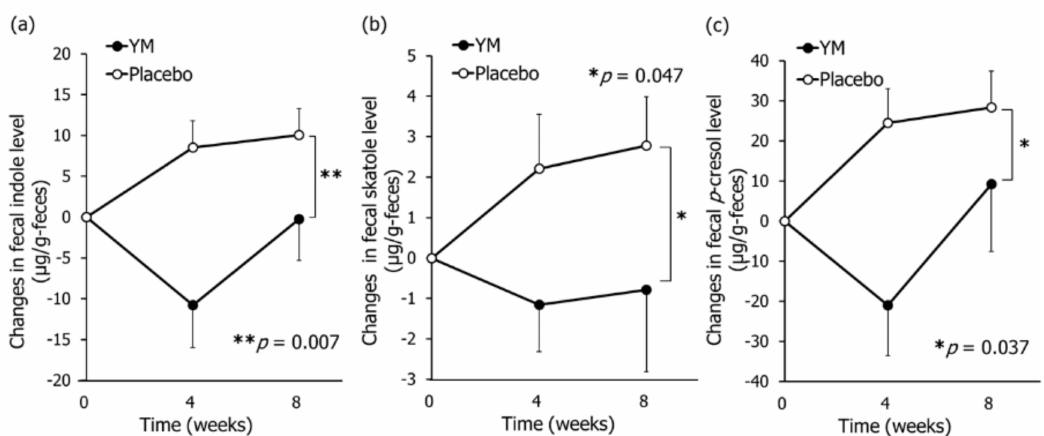
Figure 3. E ff ects of YM intake on fecal putrefactive compound levels. Changes in fecal concentrations of indole ( a ), skatole ( b ), and p- cresol ( c ). Black circles represent the YM group and the white circles represent the placebo group. Data represent the means ± SE. These were determined by repeated-measures ANOVA between groups without multiple comparison correction. Asterisks indicate overall significance between groups across time points (* p < 0.05, ** p < 0.01).